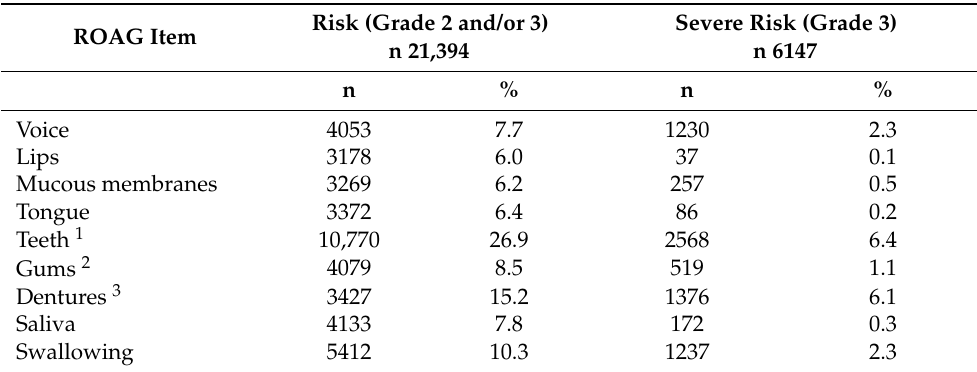
Table 3. Frequency and percentage of individuals assessed to have oral health problems (Risk or Severe risk) in each item in